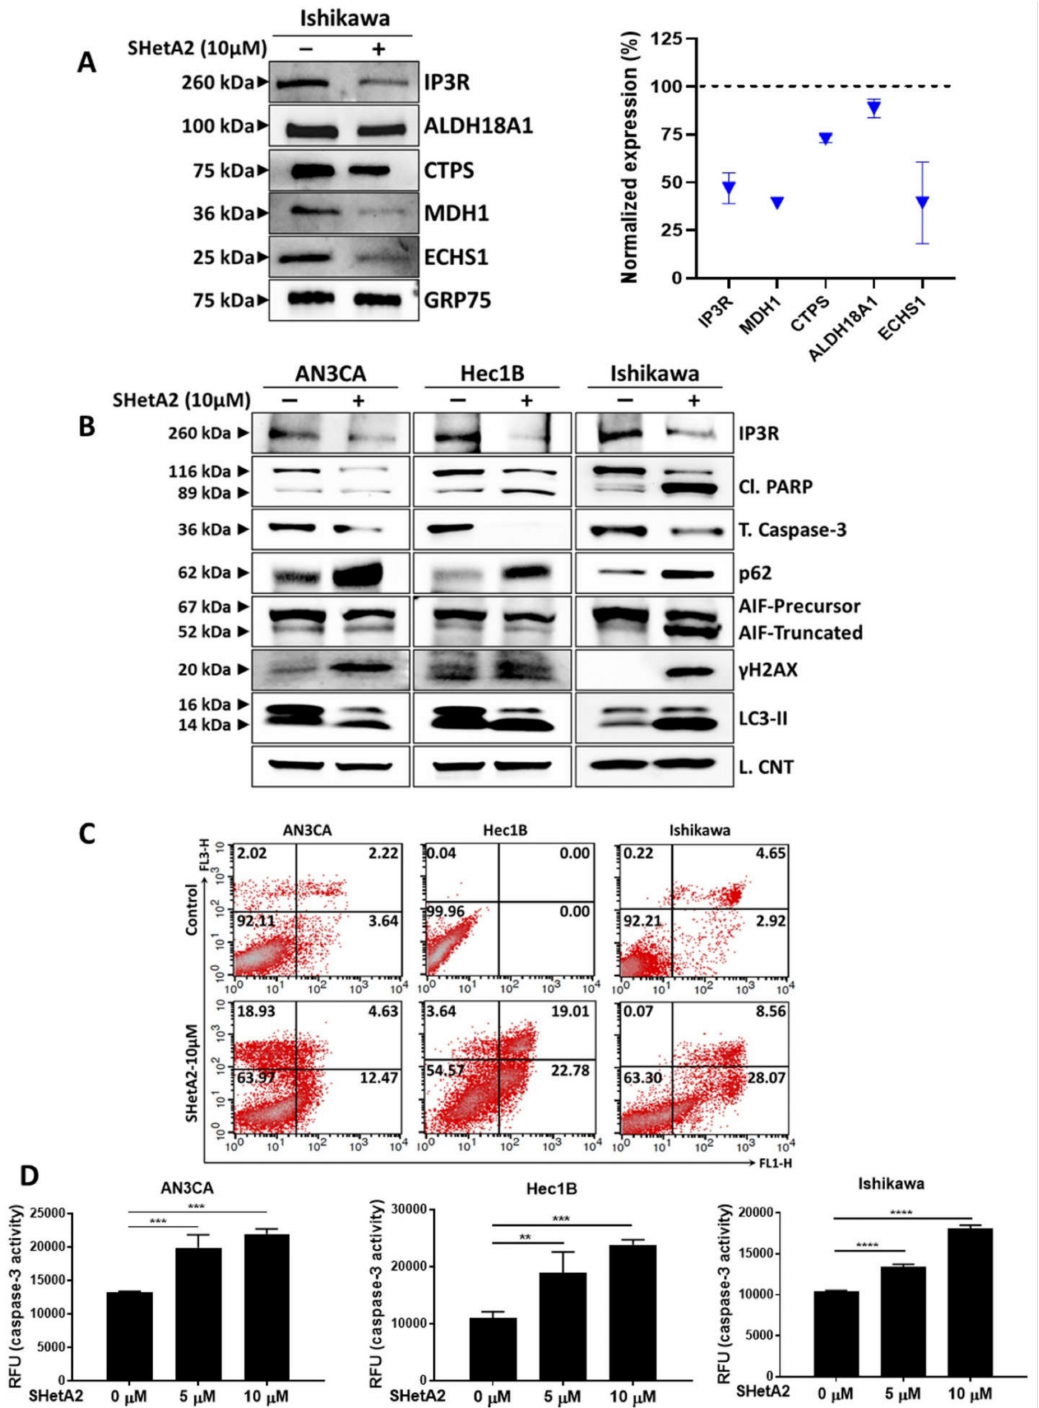
Figure 4. Molecular mechanism of SHetA2: ( A ) Ishikawa cells were treated with SHetA2 (10 µ M) for 4 h and co- immunoprecipitation was performed with mortalin antibody (Grp75)-tagged beads. Western blots (left panel) and densit- ometry analyses (right panel) was performed for IP3R, ALDH18A1, CTPS, MDH1, and ECHS1 to confirm the reduction of client protein co-immunoprecipitation. ( B ) Western blot analysis for the protein expression of IP3R, Cl. PARP, total caspase-3, P62, AIF, DNA damage marker ( γ H2AX) and LC3-II proteins in endometrial cancer cells treated with, or without, SHetA2 (10 µ M) for 24 h. ( C ) Cell apoptosis was detected by Annexin-V/PI combined labeling with flow cytometry in endometrial cancer cells 24 h after treatment with SHetA2 (10 µ M) or vehicle. ( D ) Caspase-3 activity assay for endometrial cancer cells treated with indicated dose of SHetA2 for 24 h. ** p ≤ 0.01, *** p ≤ 0.001, **** p ≤ 0.0001 when compared with respective